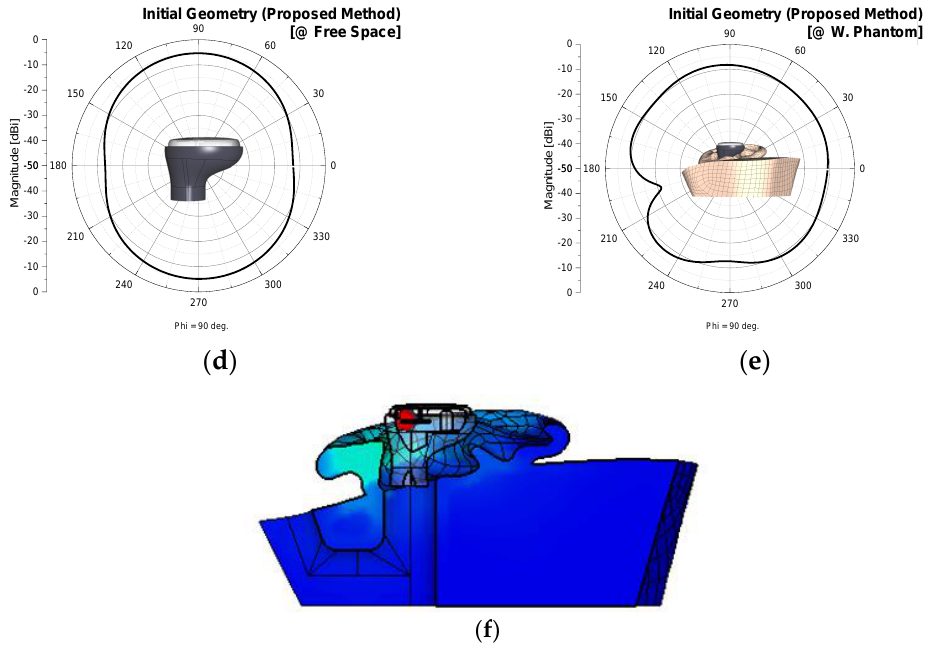
Figure 3. On− film antenna earphone in free space: ( a ) initial geometry of the proposed antenna; ( b ) layer structure; ( c ) S 11 ; ( d ) radiated field pattern in free space; ( e ) radiated field attached to the human phantom; ( f ) SAR. Table 2. The physical dimensions of the antenna combined with the AMC.